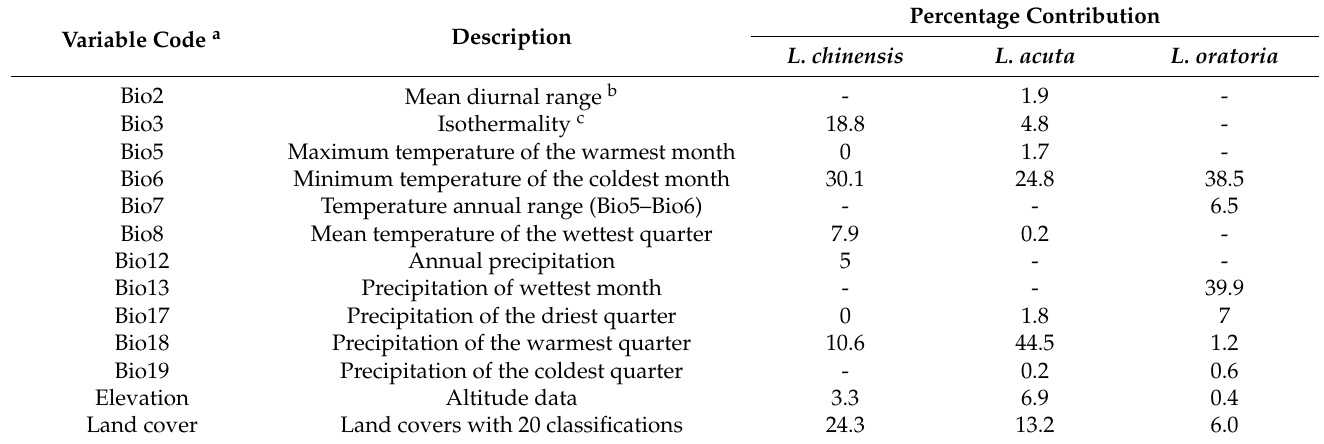
Table 1. List of selected environmental variables for each